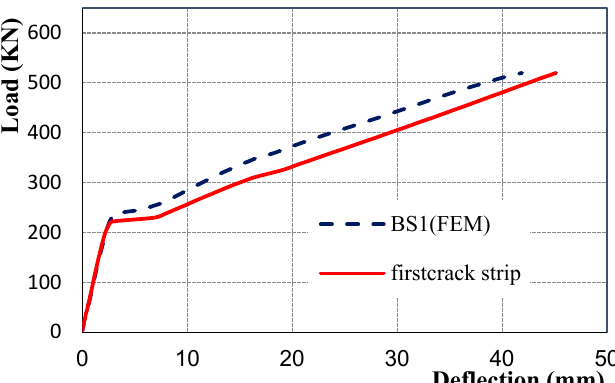
Figure 35. Comparison between column laminate results with BS1.